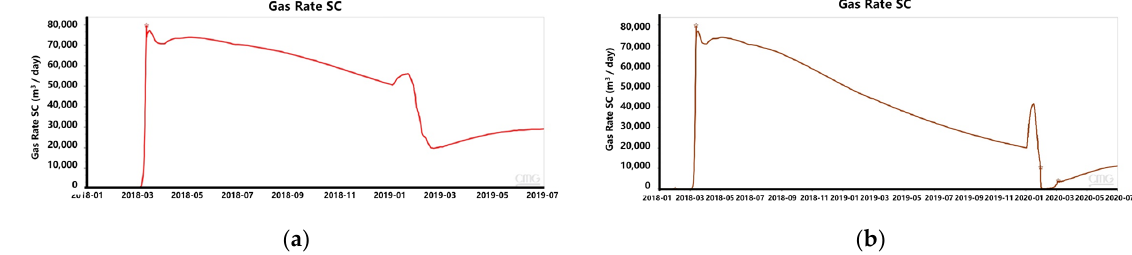
Figure 12. Gas rates of ( a ) Scenario 7 and ( b ) Scenario 8.